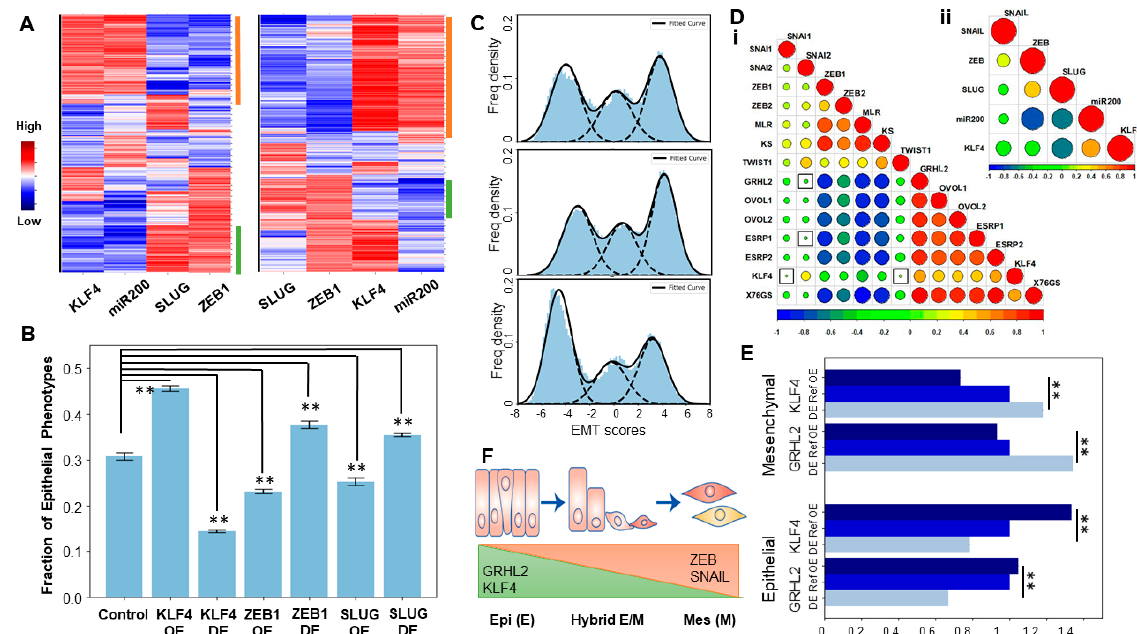
Figure 2. KLF4 promotes an epithelial phenotype. ( A ) ( Left ): Heatmap showing the steady-state values of all the components of the KLF4–EMT-coupled circuit, obtained across the parameter sets simulated by RACIPE. ( Right ) Same as the left panel but for KLF4 overexpression. ( B ) Change in the fraction of the epithelial phenotype due to the simulated overexpression or downregulation of either KLF4 or ZEB1 or SLUG. Error bars for n = 3 independent simulations. ( C ) Frequency density of the epithelial, hybrid, and mesenchymal phenotypes obtained using the EMT scores. ( Top ) KLF4 circuit, ( middle ) KLF4 circuit with KLF4 down-expression (DE), and ( bottom ) KLF4 circuit with KLF4 overexpression (OE). ( D ) Pairwise Pearson’s correlation matrix. ( i ) Correlation of the epithelial and mesenchymal players and EMT scoring metrics (76GS, KS, and MLR) in the CCLE cell lines. ( ii ) Correlation of the RACIPE-simulated expression values of the nodes in the KLF4 network. Squares indicate a p -value > 0.01. ( E ) Change in the size of the epithelial and mesenchymal clusters upon OE and DE of GRHL2 and KLF4. ( F ) Schematic showing the variations of the KLF4, GRHL2, ZEB1, and SNAIL levels across the EMT spectrum. **: p < 0.01.